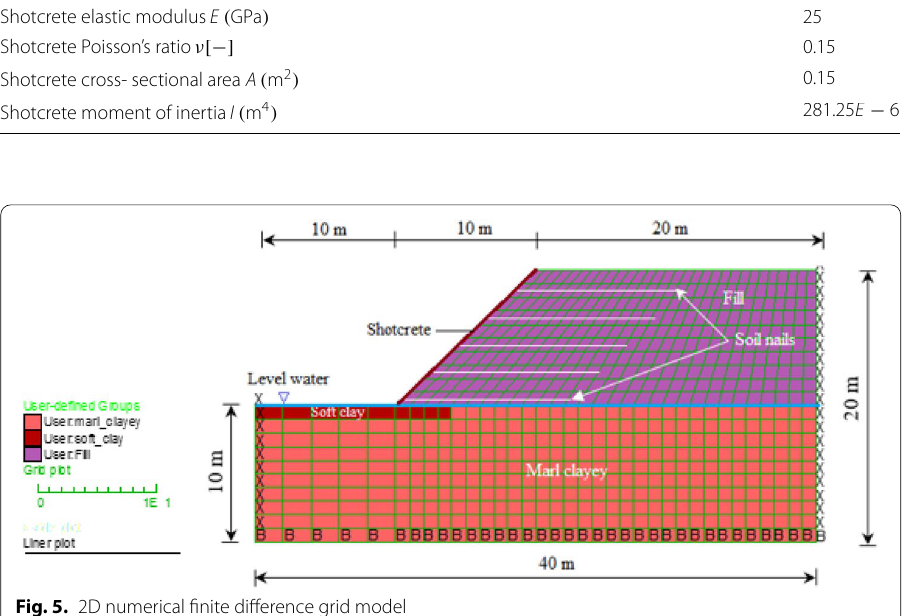
Fig. 5. 2D numerical finite difference grid